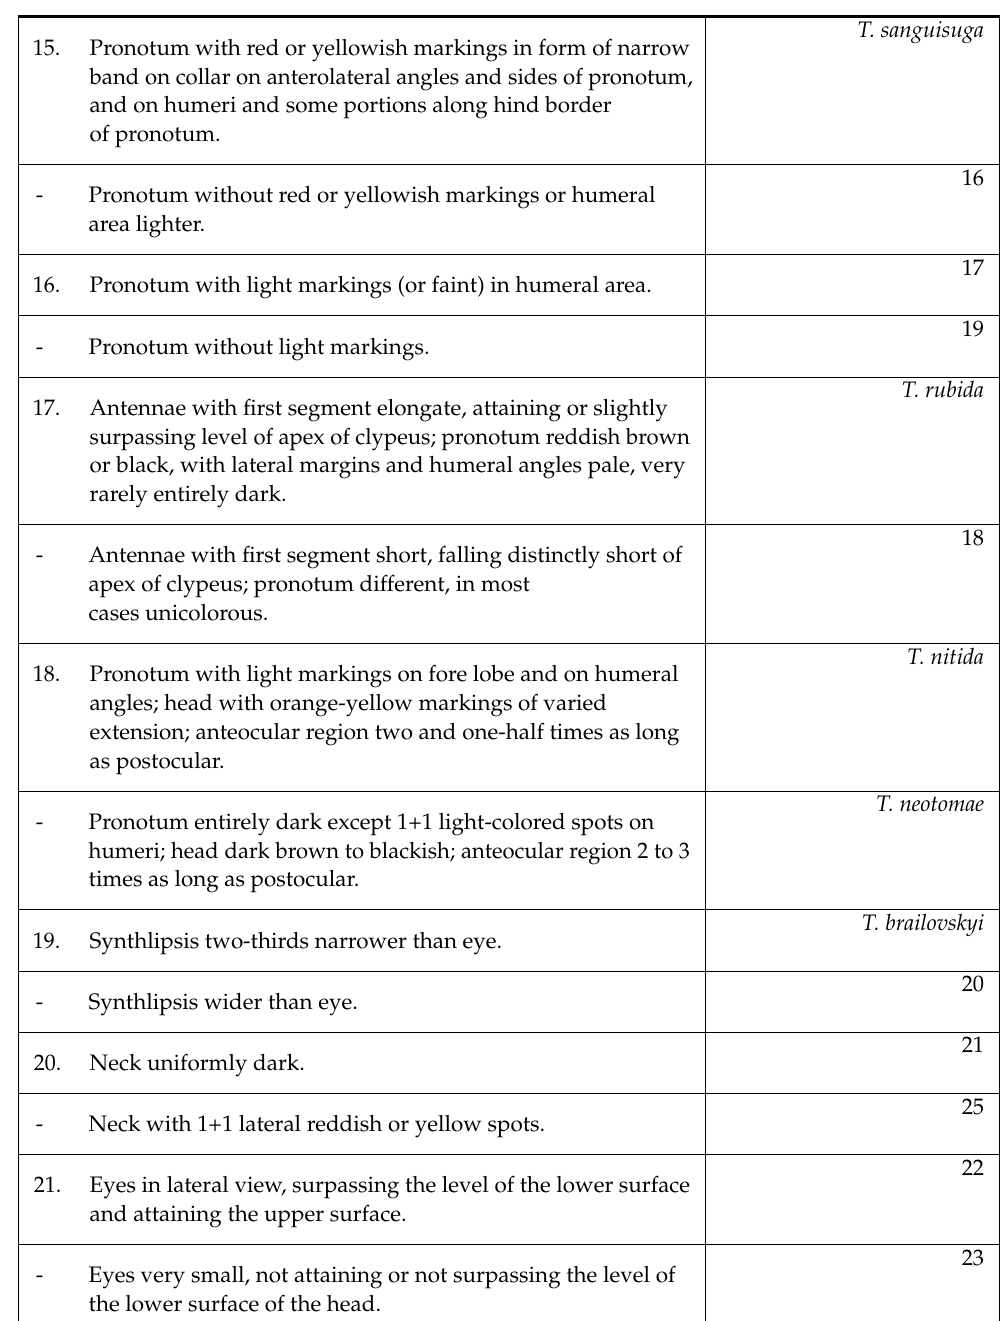
15. Pronotum with red or yellowish markings in form of narrow band on collar on anterolateral angles and sides of pronotum, and on humeri and some portions along hind border of pronotum.